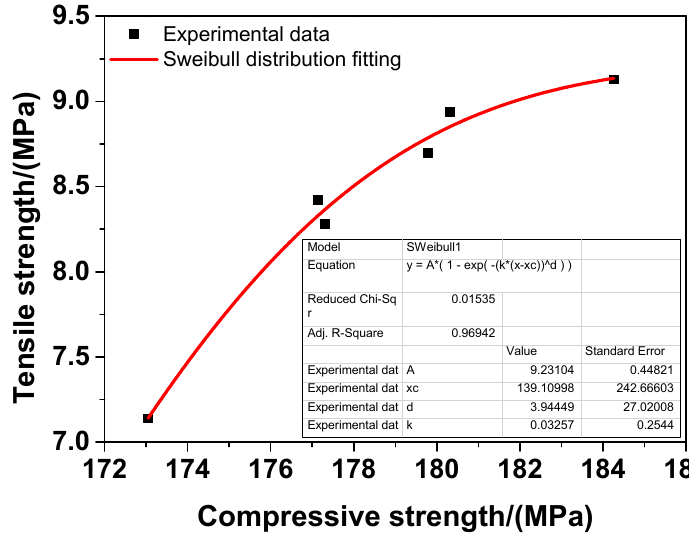
Figure 7. Relationship between tensile strength and compressive strength of UHPC.